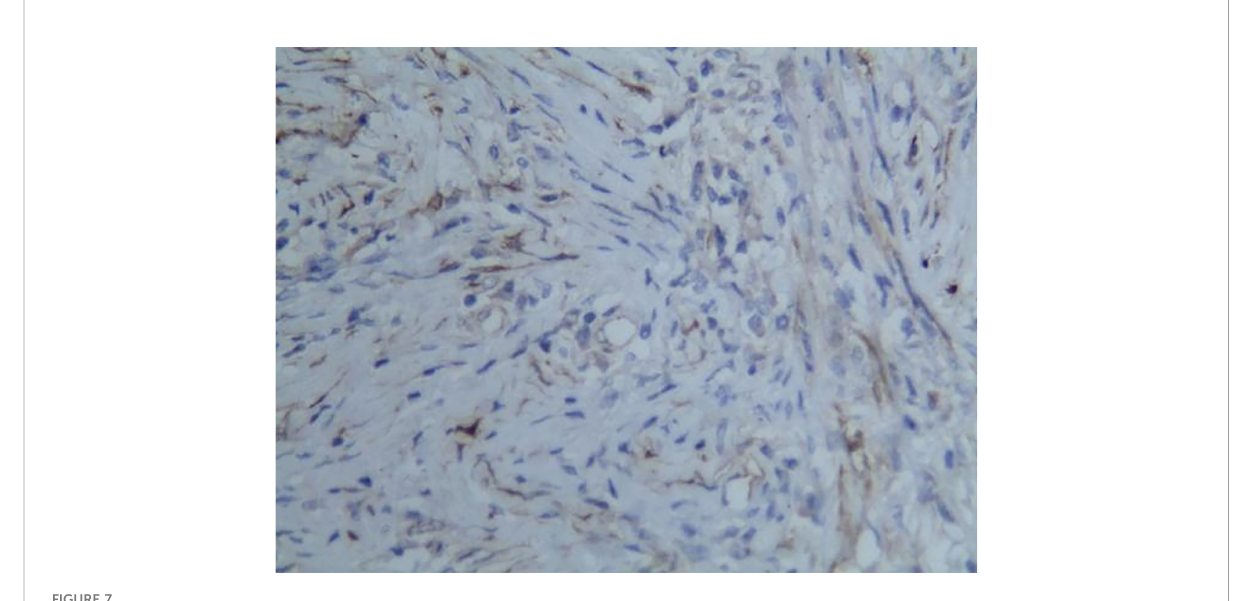
FIGURE 7 Representative image of calponin expression (magni fi cation, ×200).